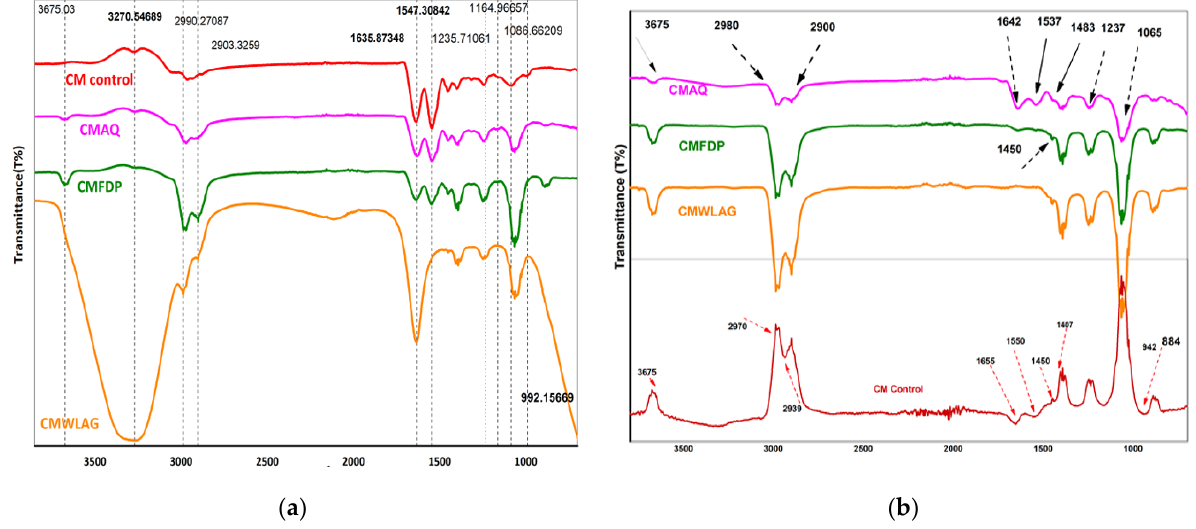
Figure 4. FTIR spectra of controlled casein micelles (CM control) and spray-dried microcapsules of CMAQP, CMFDP, and CMWLAG before ( a ) [14] and after spray-drying ( b ).